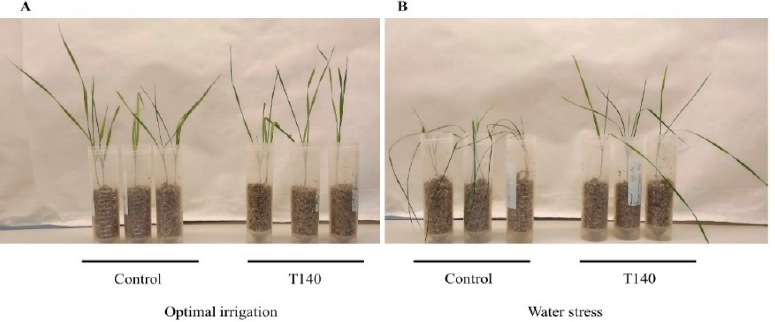
Figure 2. Four-week-old wheat seedlings treated with Trichoderma asperellum T140 or untreated (control) and subjected to two irrigation regimes: ( A ) optimal irrigation and ( B ) water stress (irrigation withdrawn during the third and fourth weeks).